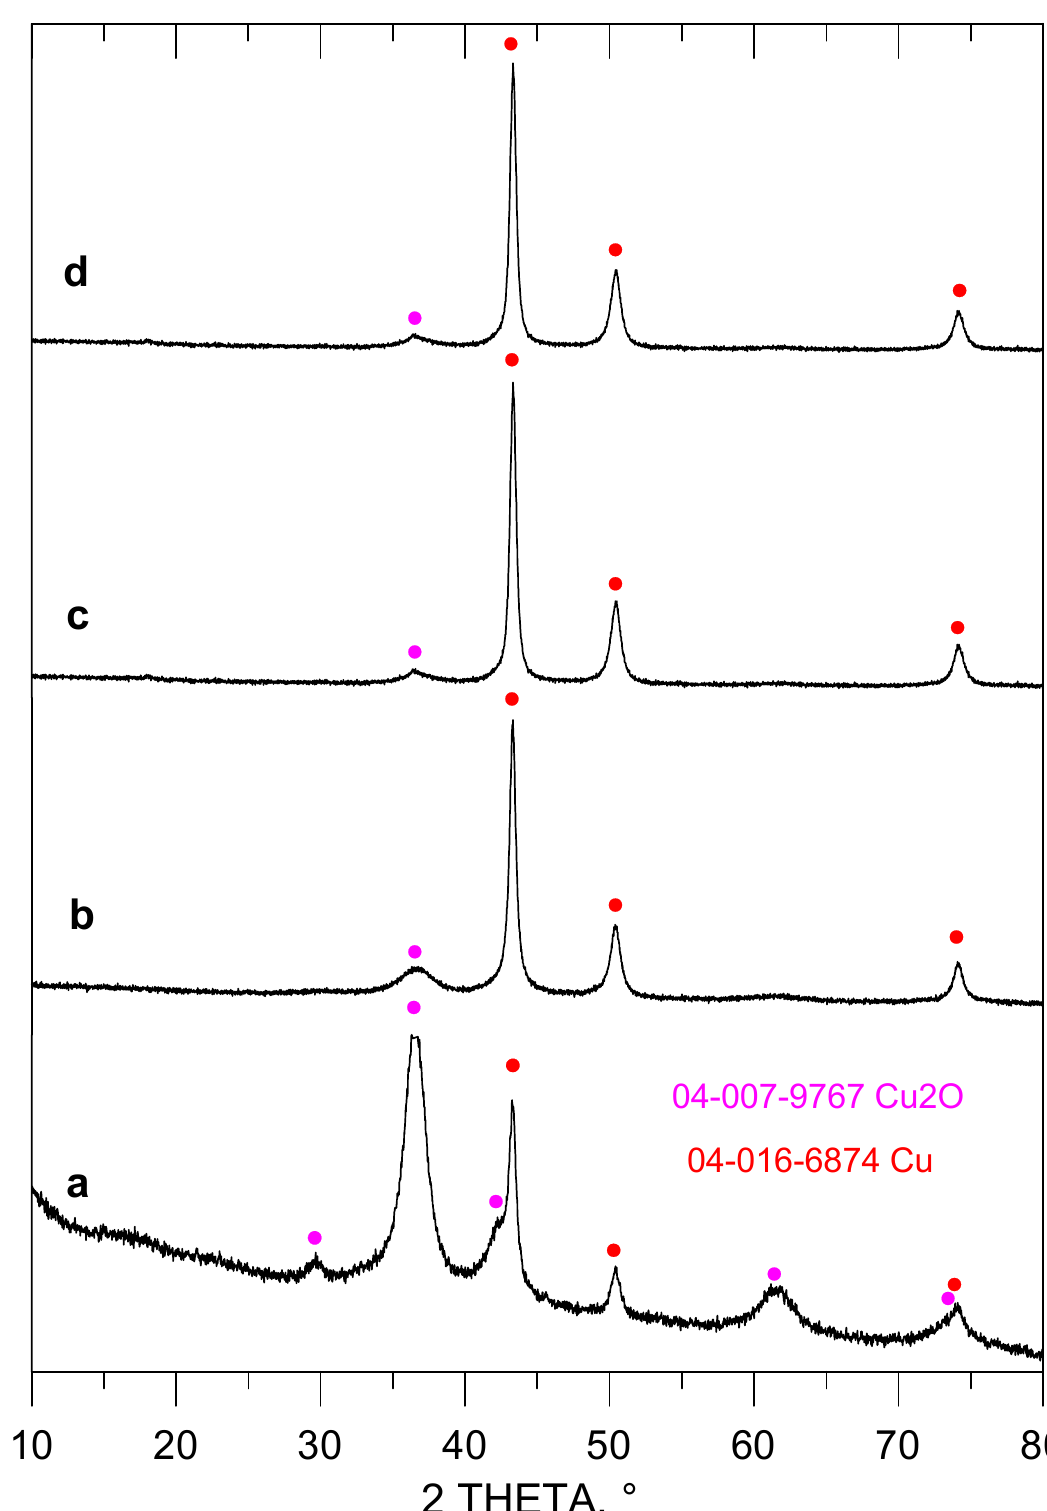
Figure 11. Powder X-ray diffractograms of insoluble part after HDB of BRX (5 mM solution in 20 mM aq. NaOH) mediated by: ( a ) CuSO 4 .5 H 2 O (8.33 g/L) + NaOH (2.8 g/L) + NaBH 4 (6.67 g/L); ( b ) CuSO 4 .5 H 2 O (8.34 g/L) + NaOH (2.6 g/L) + NaBH 4 (6.67 g/L); ( c ) NaBH 4 (8 g/L) + CuO nanopowder (3.7 g/L); ( d ) NaBH 4 (8 g/L) + Cu 2 O (3.7 g/L).